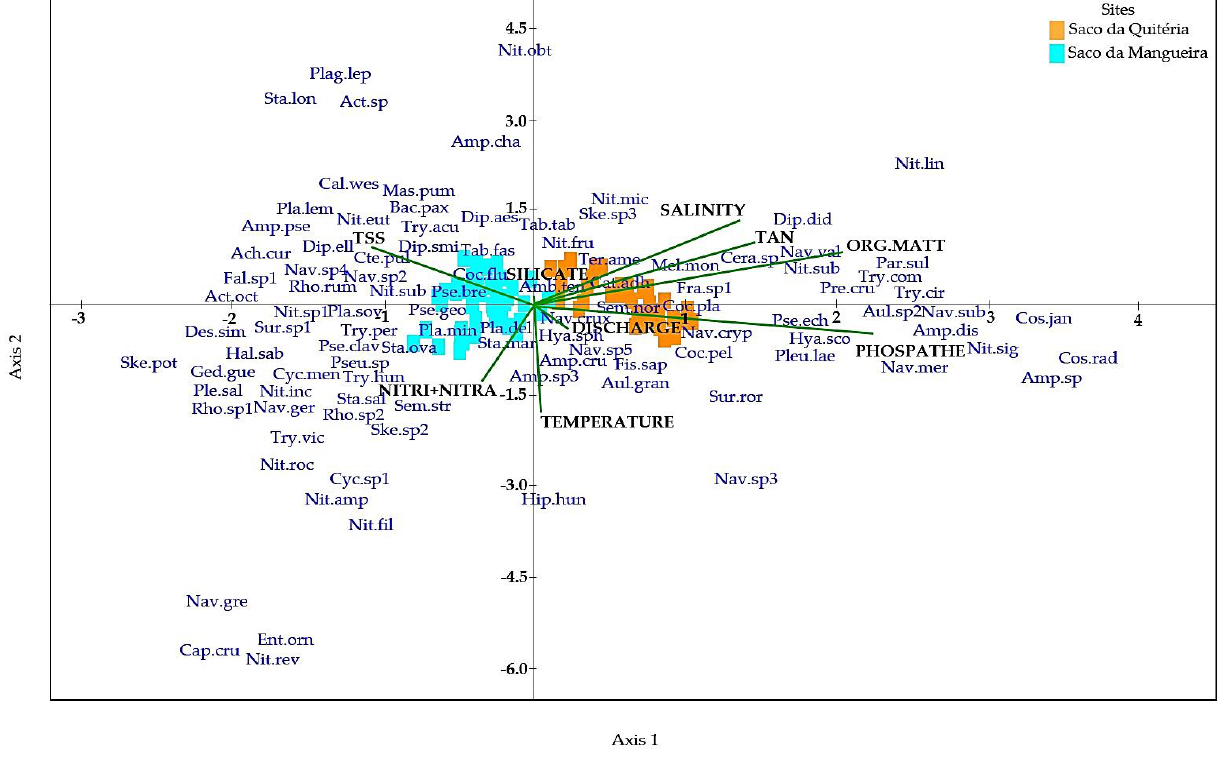
Figure 8. Canonical correspondence analysis (CCA) of the epiphytic diatom community in relation to environmental variables across the entire study period (November 2015 to February 2018) at both sites (Saco da Quitéria and Saco da Mangueira). Taxa with a frequency greater than 5%. Transformed data log (x + 1).